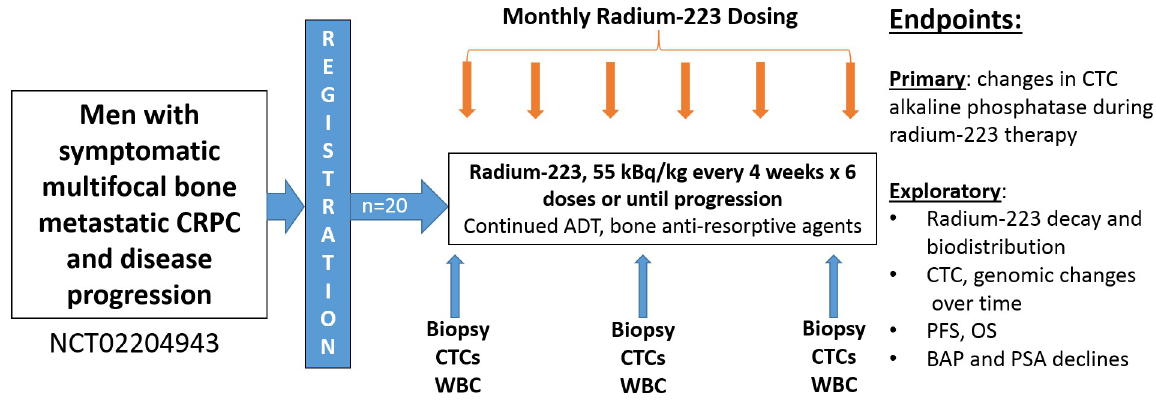
Fig 1. Schema for patient flow for the radium-223 pharmacodynamic study.